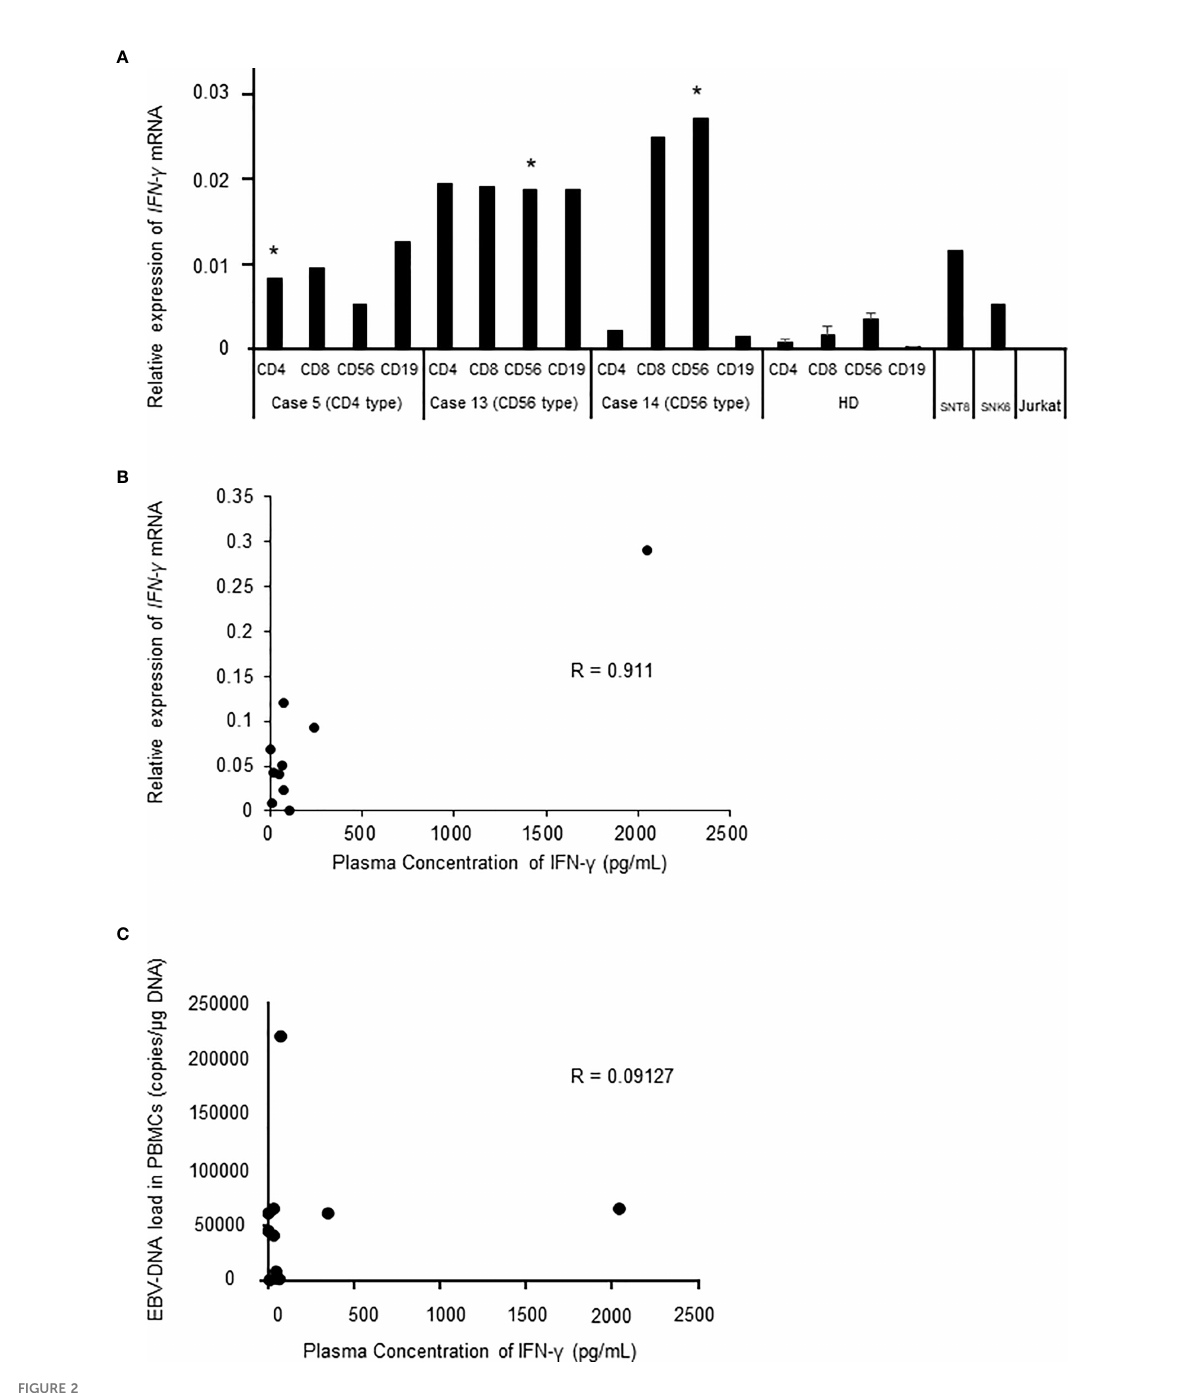
FIGURE 2 The mRNA expression of IFNG in sCAEBV patients (A) . IFNG expression of sCAEBV patients by lymphocyte fraction. EBV-infected cell fractions are indicated as *. SNT8 cells and SNK6 cells are positive controls. Jurkat cells are negative control. HD: healthy donors. (B) . The correlation between mRNA expression and the plasma levels of IFN- g in sCAEBV patients. R: correlation coef fi cient. (C) . The correlation between EBV-DNA load in the peripheral blood mononuclear cells (PBMCs) and the plasma levels of IFN- g in sCAEBV